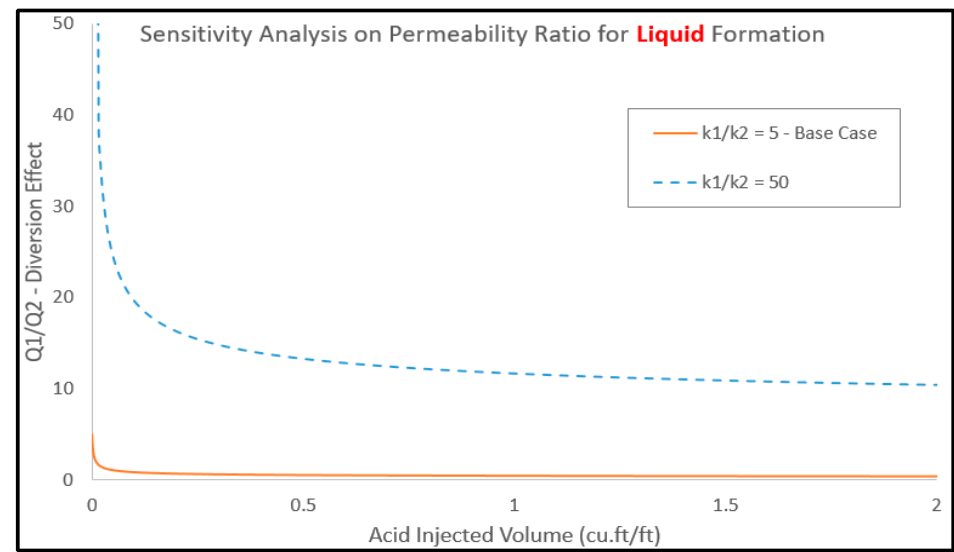
Figure 16. Effect of formation porosity on acid diversion performance.